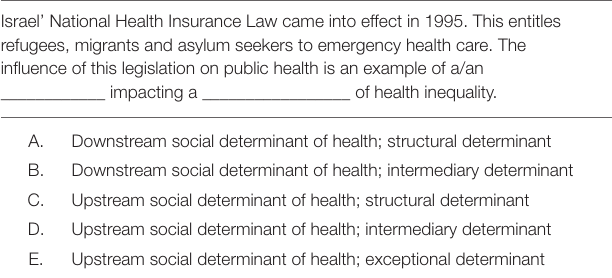
TABLE 6 | MCQ example testing understanding and